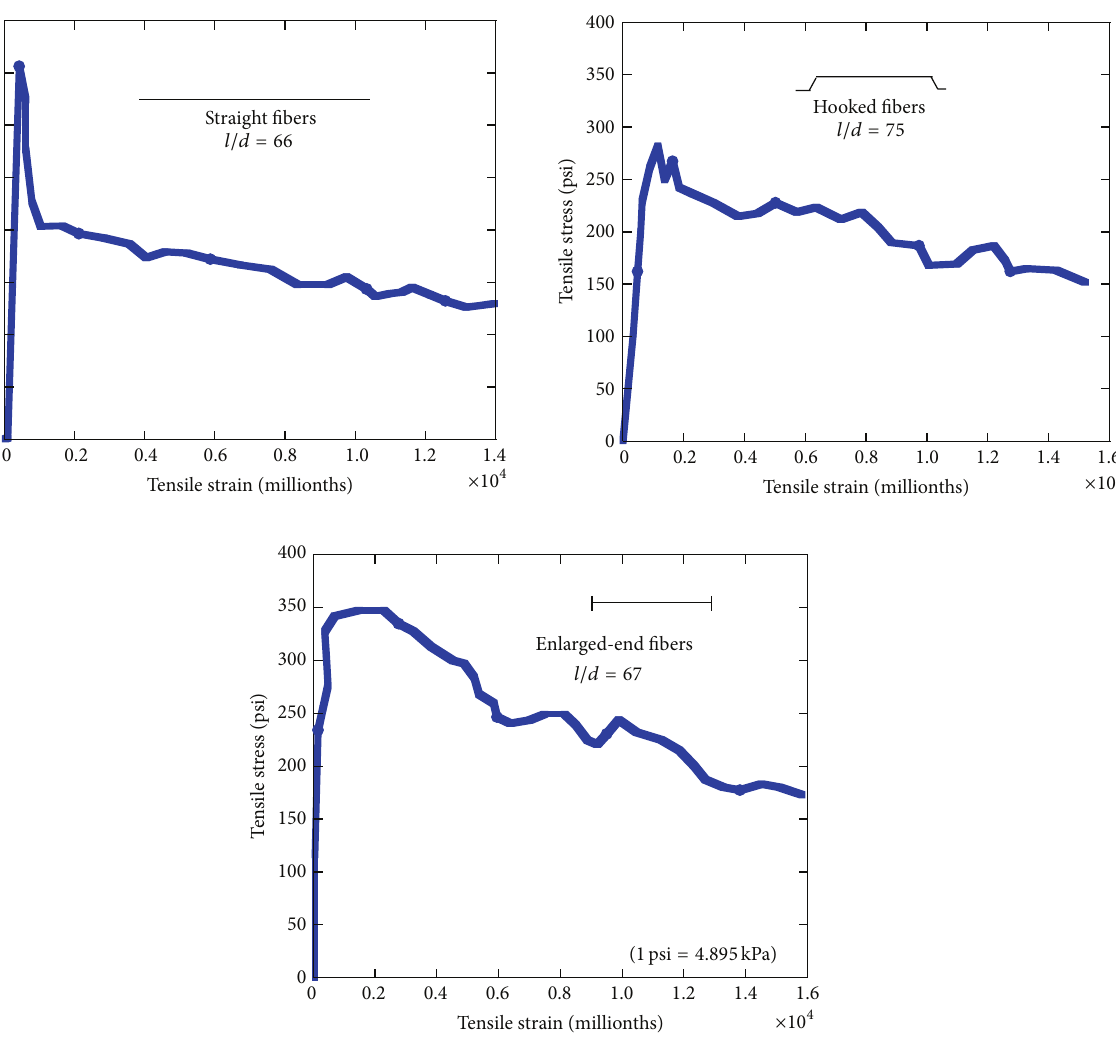
Figure 2: Stress-strain curves for steel fiber reinforced mortars in tension as per ACI-544.4R-88 [5].